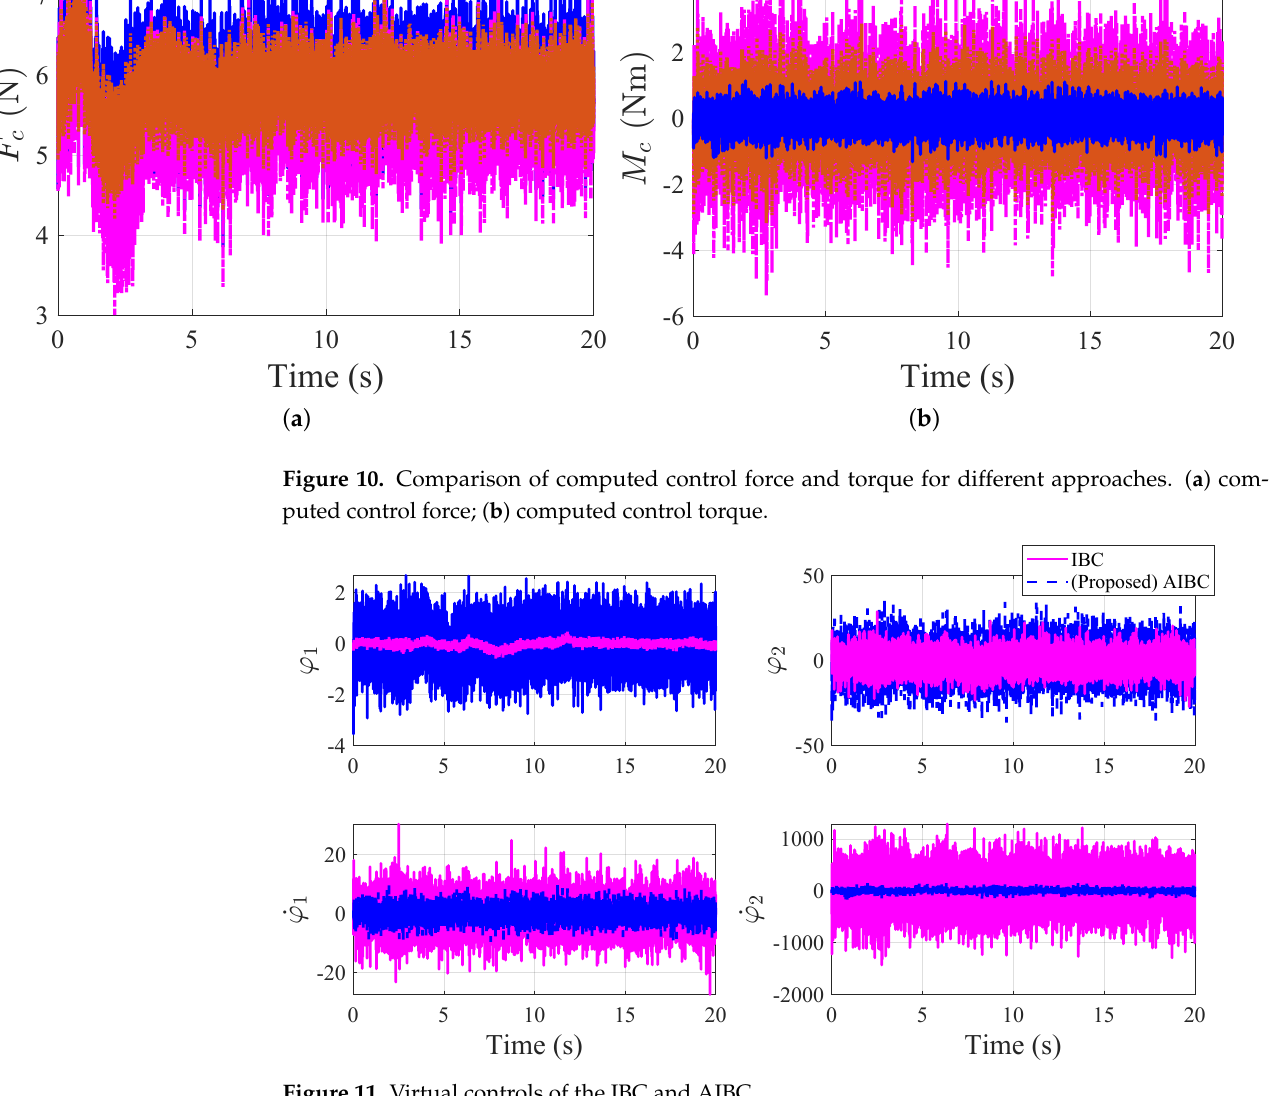
Figure 11. Virtual controls of the IBC and